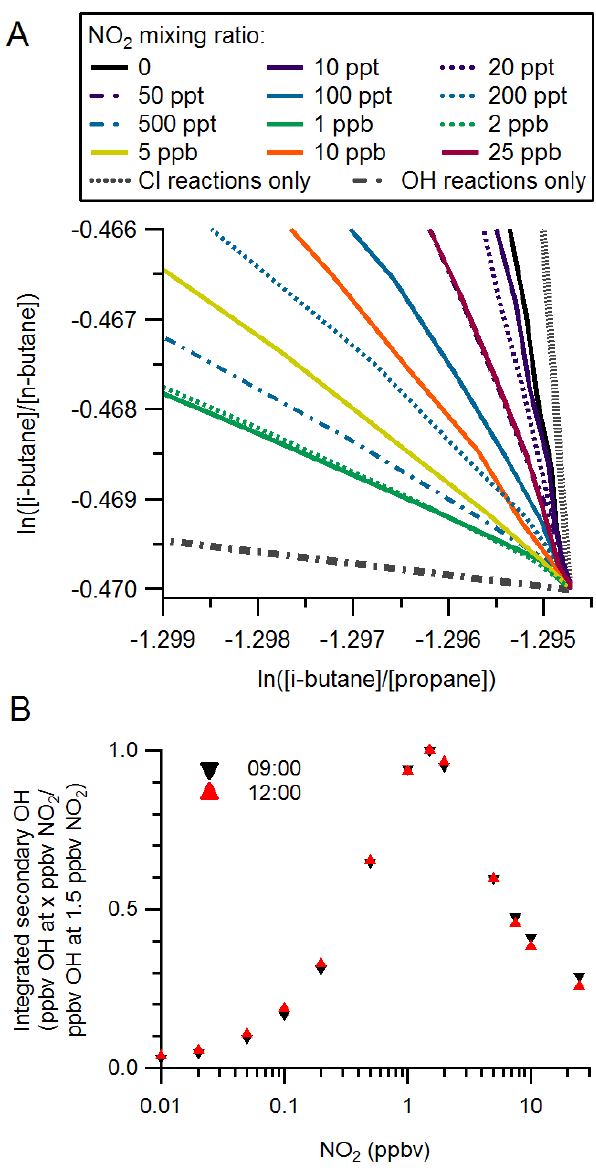
Fig. 4. MCM calculation results of ClNO 2 -initiated chemistry with different NO x conditions (Condition Set 2): (A) evolution of one set of VOC tracer ratios ( i -butane, n -butane, and propane), and (B) integrated secondary OH under varying conditions of NO 2 . Note that the x and y axis scales in (A) are expanded relative to Fig. 2 to show the influence of NO 2 on VOC